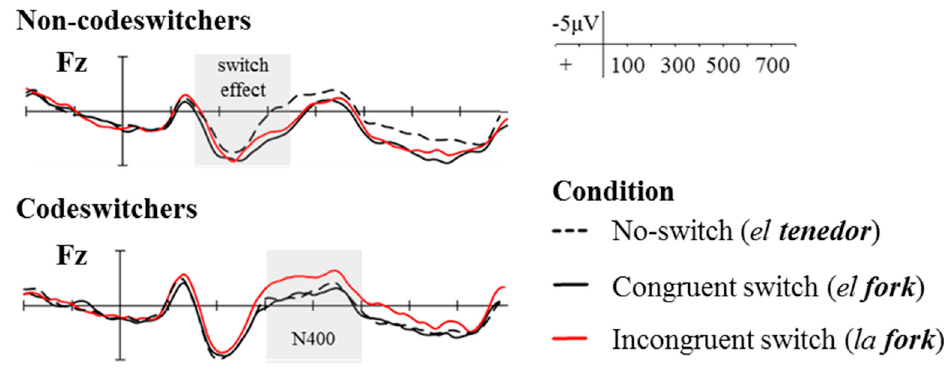
Figure 5. Event-related potentials time-locked to the onset of masculine switched and non-switched nouns (emboldened) for non-codeswitchers ( top ) and codeswitchers ( bottom ) at the electrode site frontal zero (Fz) 5 (adapted from Journal of Memory and Language, 95, Beatty-Martínez and Dussias, Bilingual experience shapes language processing: Evidence from codeswitching, 173–89, Copyright (2017), with permission from Elsevier).